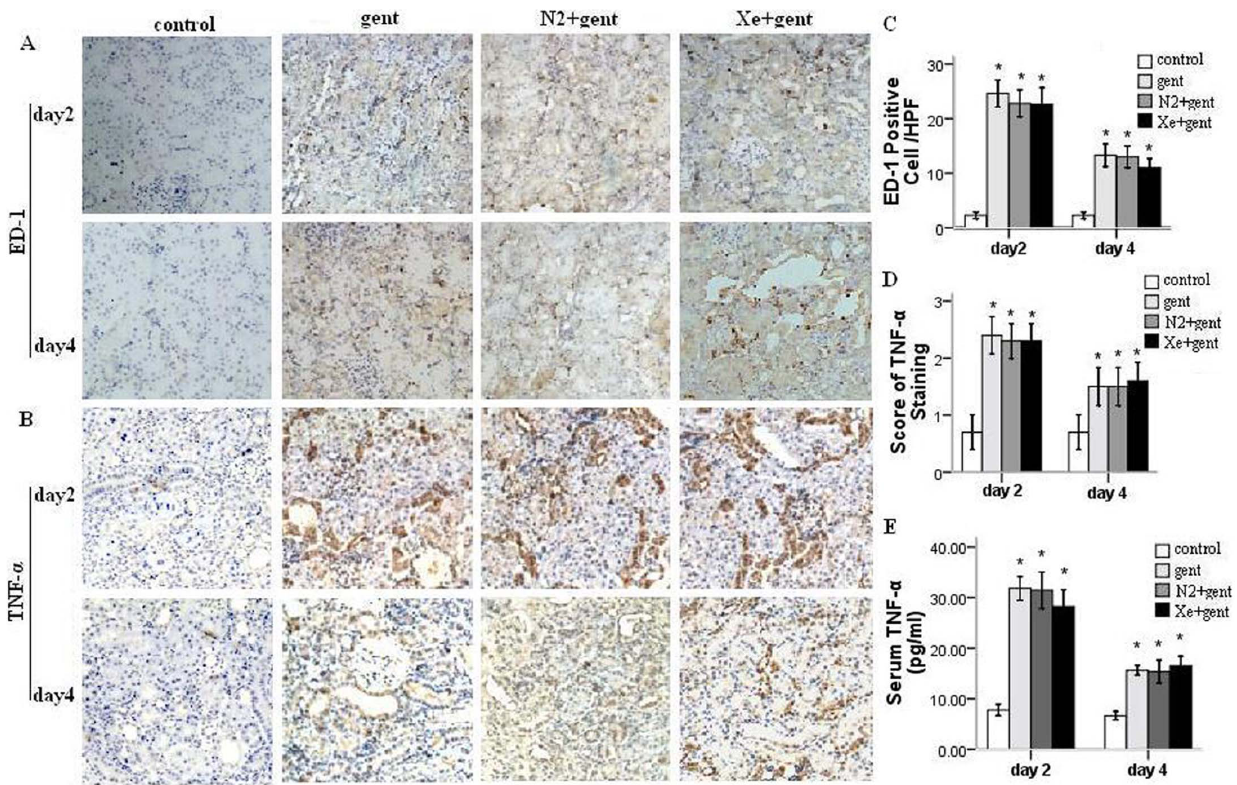
Figure 4. Immunohistochemical staining of ED-1 and TNF- a in renal sections. Representative photomicrographs, 100 6 , A–B: brown color indicates positive staining. A: the expression of ED-1 in kidneys 2 and 4 days after 7-day gentamicin injection. B: the expression of TNF- a in kidneys. C: mean value of ED-1 positive cells in renal sections from all groups. D: scores of TNF- a staining-positive areae in renal sections from all groups. E: Serum TNF- a level. There were no significant difference in expression of ED-1 and TNF- a in kidney between gentamicin group, N 2 + gentamicin group and Xe + gentamicin group. The level of serum TNF- a was not significantly different between the experimental groups. *P , 0.01 vs. control group, n=6/group at each time point.